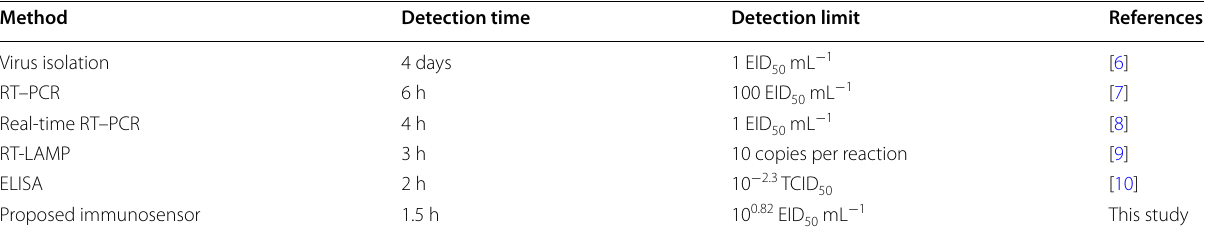
Table 2 Comparison of the proposed immunosensor with other methods for AIV H9 detection